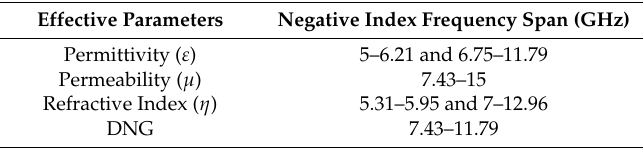
Table 2. Summary of the effective parameters of the unit cell.